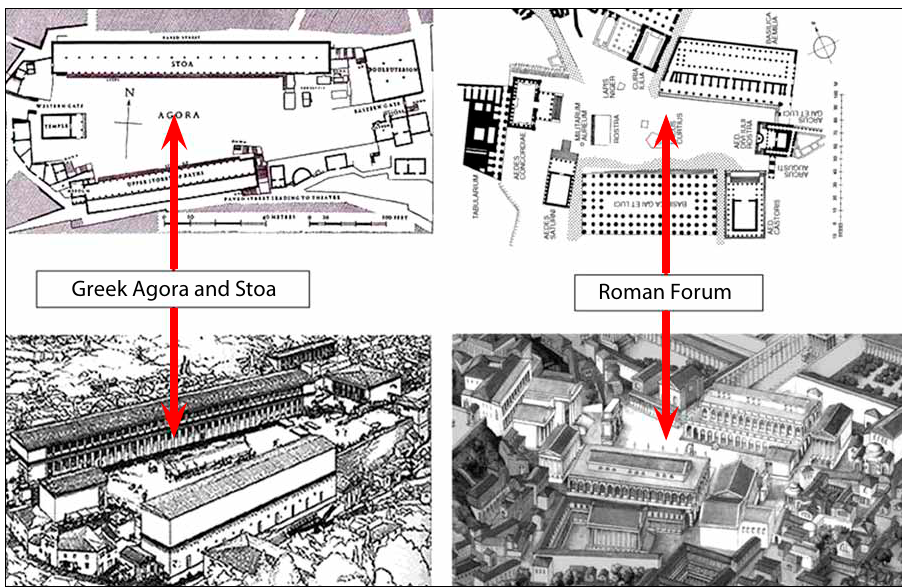
fig. 2. assos agora with its double-storey Doric order and a temple built in the 2 nd century (left) compared with the first forum romanum that formed similar architectural forms and spatial alignment but with different functions (right). Source : modified from http://www.exploreturkey.com/ asos.htm,